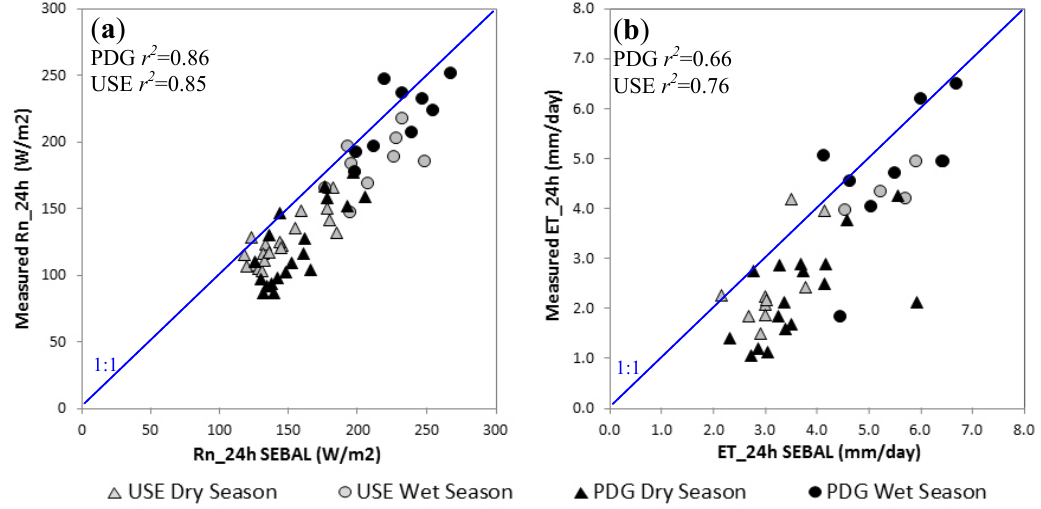
Figure 6. Comparison between daily net radiation ( a ) and daily evapotranspiration ( b ) estimations and in situ measured data in areas of savannas (PDG site) and sugarcane croplands (USE